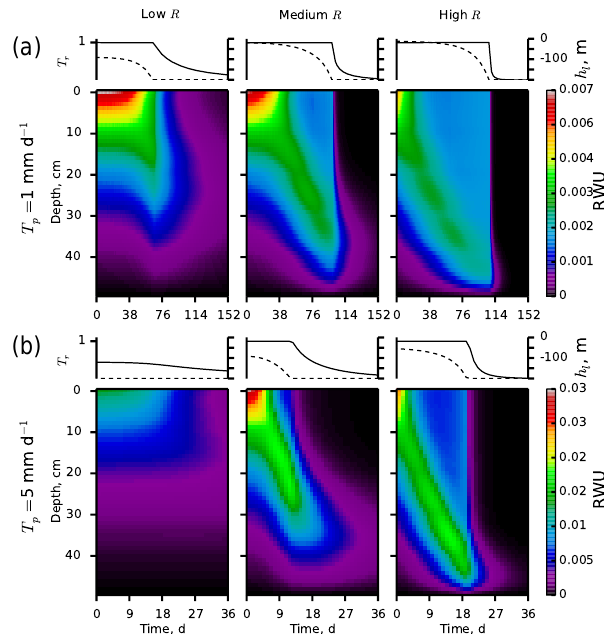
Figure 4. Time–depth root water uptake (RWU, d − 1 ) pattern, leaf pressure head ( h l , dashed line), and relative transpiration ( T r , con- tinuous line) simulated by the SWAP model together with the De Jong van Lier et al. (2013) model for clay soil, two levels of poten- tial transpiration T p : 1 and 5mmd − 1 (first and second lines of the plots, respectively), and three levels of root length density R : low, medium, and high (indicated at the top of the